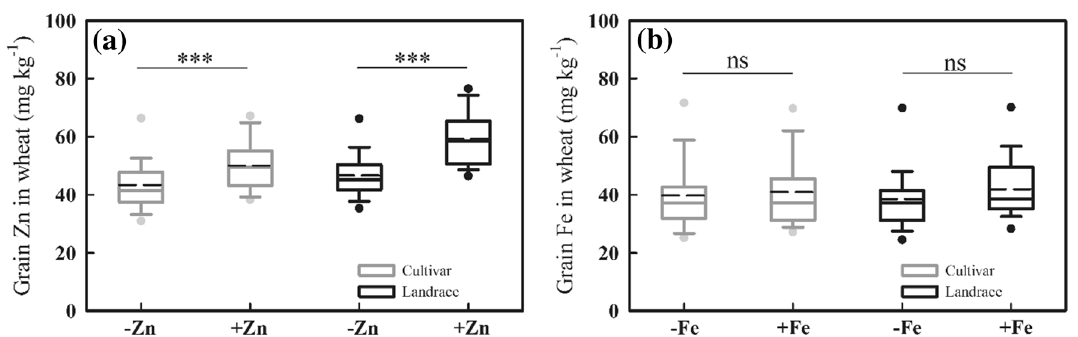
Figure 5. Effects of foliar application of micronutrients on the grain concentrations of ( a ) zinc and ( b ) iron of Chinese wheat landraces (n = 28) and cultivars (n = 65). Note: The box boundaries indicate upper and lower quartiles; the whiskers indicate the 90th and 10th percentiles; the circles indicate the 95th and 5th percentiles; the solid and dashed horizontal lines indicate median and mean, respectively. * * * is statistically significant at P < 0.001, ns indicate not significant at P <